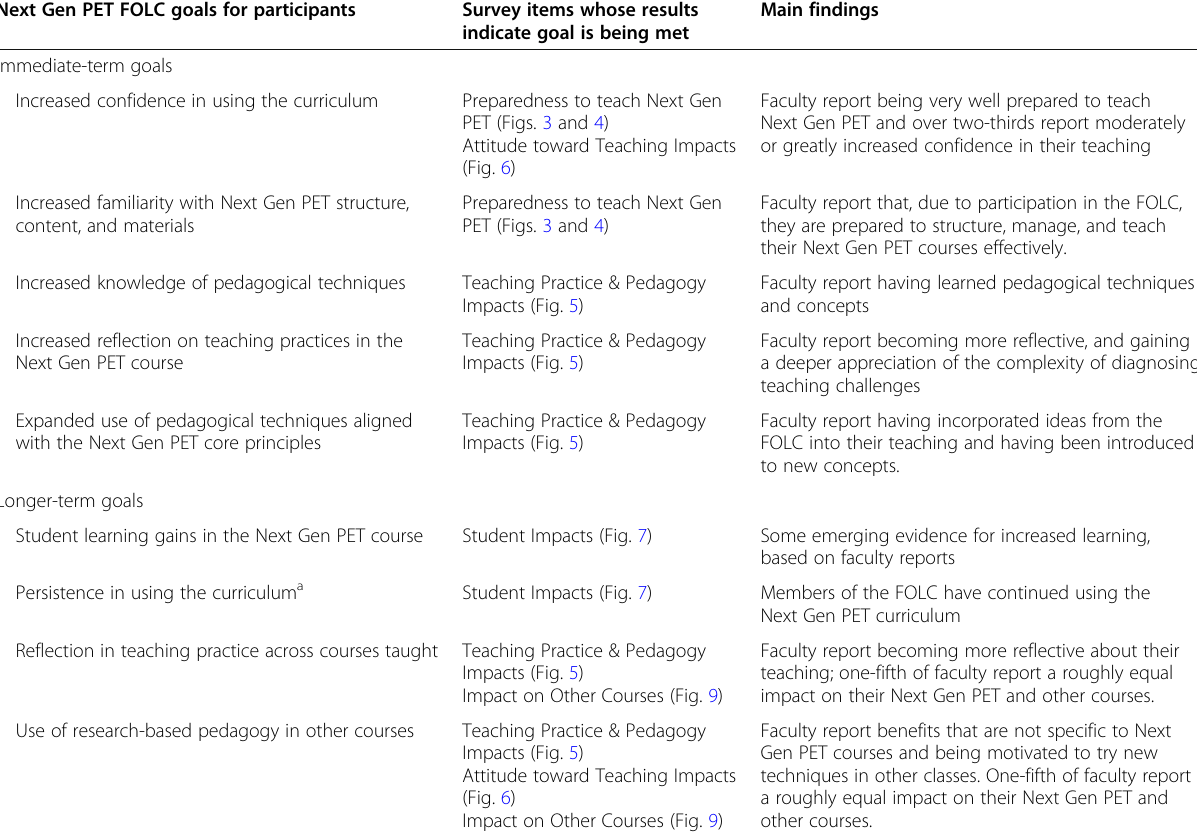
Table 4 Summary of survey results showing the Next Gen PET FOLC outcomes are being met Next Gen PET FOLC goals for participants Survey items whose results indicate goal is being